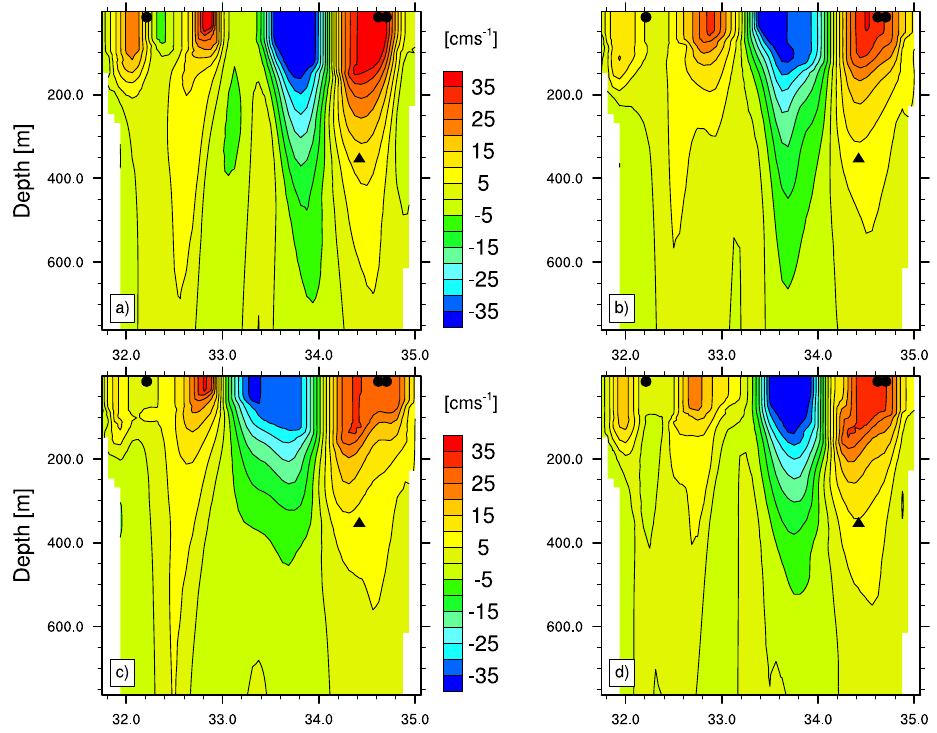
Fig. 6. Zonal velocity transect across the Cretan Passage (26 ◦ E) on 22 December 2005: (a) CTRL, (b) SURF, (c) SURF2, and (d) ARGO. The surface drifter (Argo float) positions on 21 December are indicated by the black dots